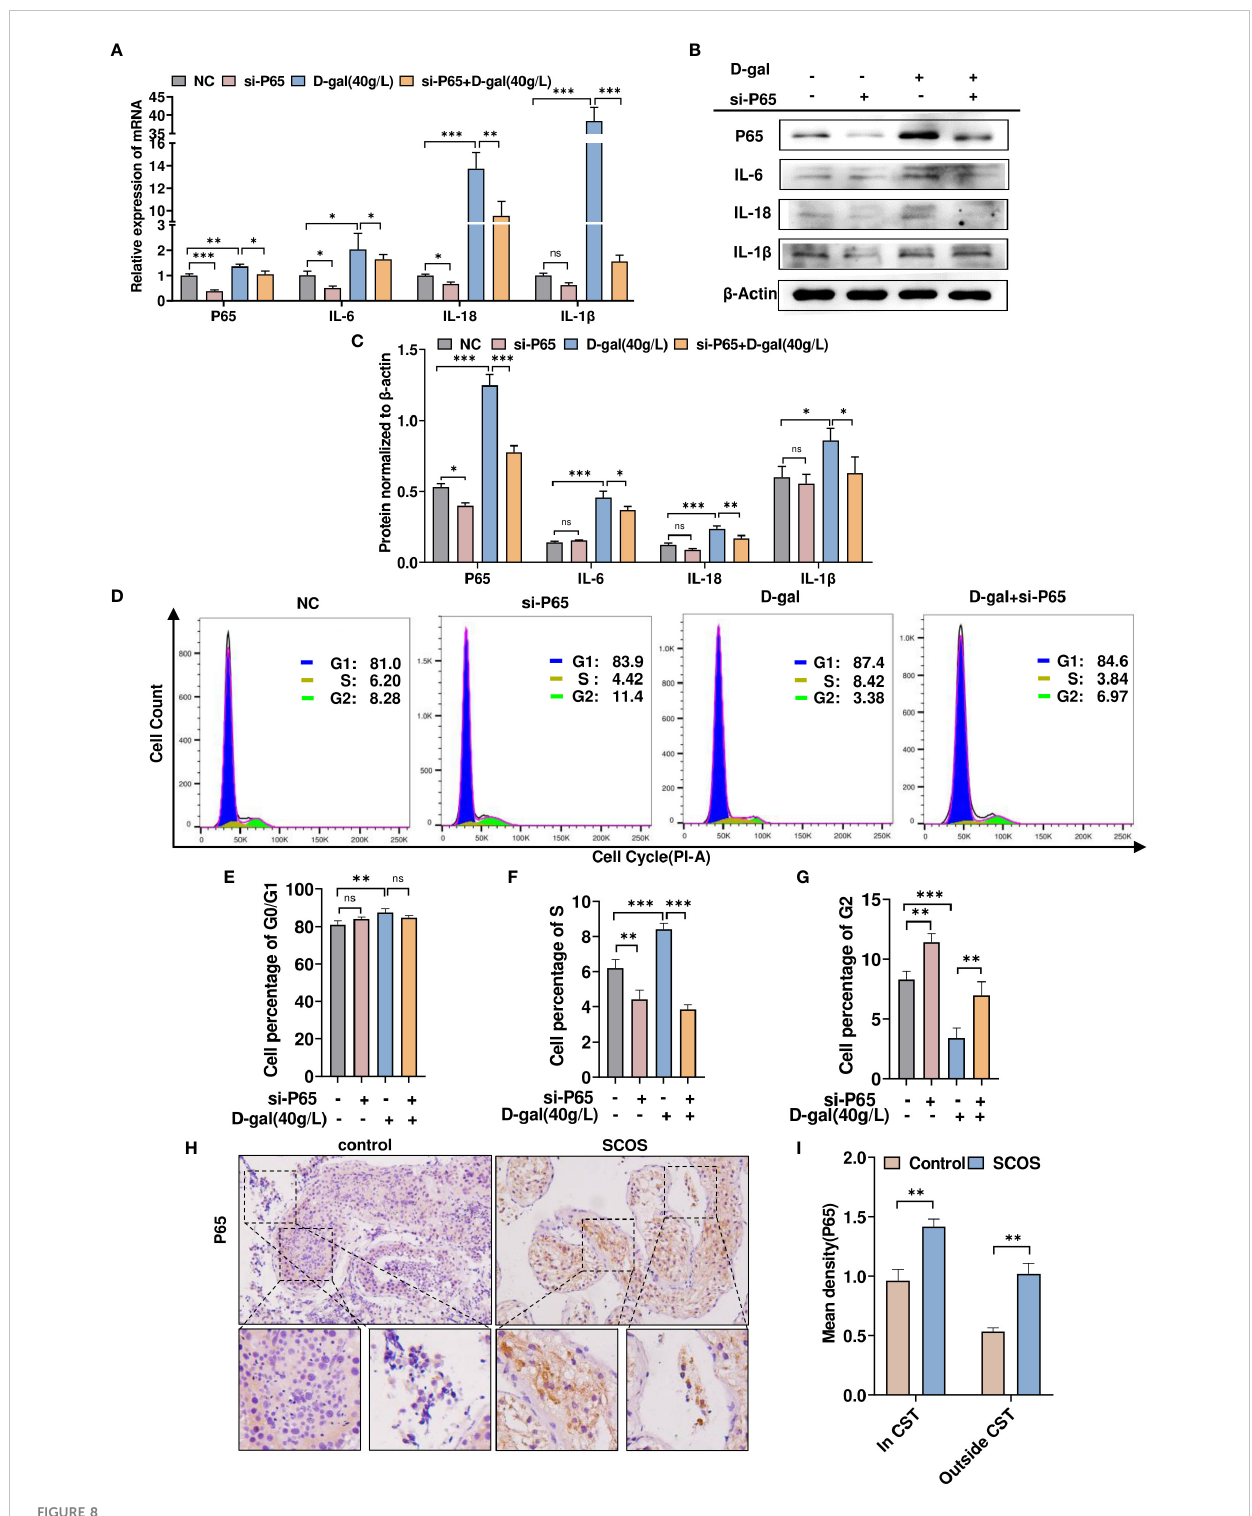
FIGURE 8 p65 mediates D-gal-induced testicular cell growth and in fl ammation in SCOS. (A, B) RT – qPCR and Western blot analysis were used to detect p65, IL-1 b , IL-18, and IL-6 expression in cells transfected with siRNA-p65 and D-gal alone or in combination. (C) The panel shows the grayscale analysis of data presented in (B) . (D) Flow cytometry analysis of the cell cycle in the four cell groups in (A) showed the percentage of cells at various phases of division. (E – G) These graphs indicate the changes in G0/G1, S, and G2 phases in different cell groups. ** p < 0.01, *** p < 0.001; ns indicates no statistical signi fi cance. (H) Immunohistochemical staining revealed p65 expression in testes with normal spermatogenesis and those with SCOS. (I) Average p65 staining intensity in and outside CST. **p < 0.01 vs . the control group. Scale bar: 50 m m. Original magni fi cation: